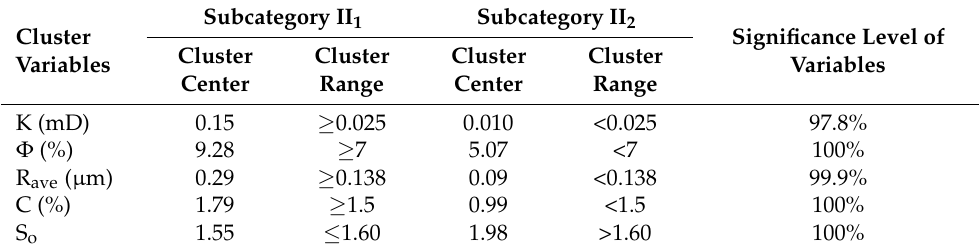
Table 8. Final cluster center and cluster range of subcategories II 1 and II 2 .